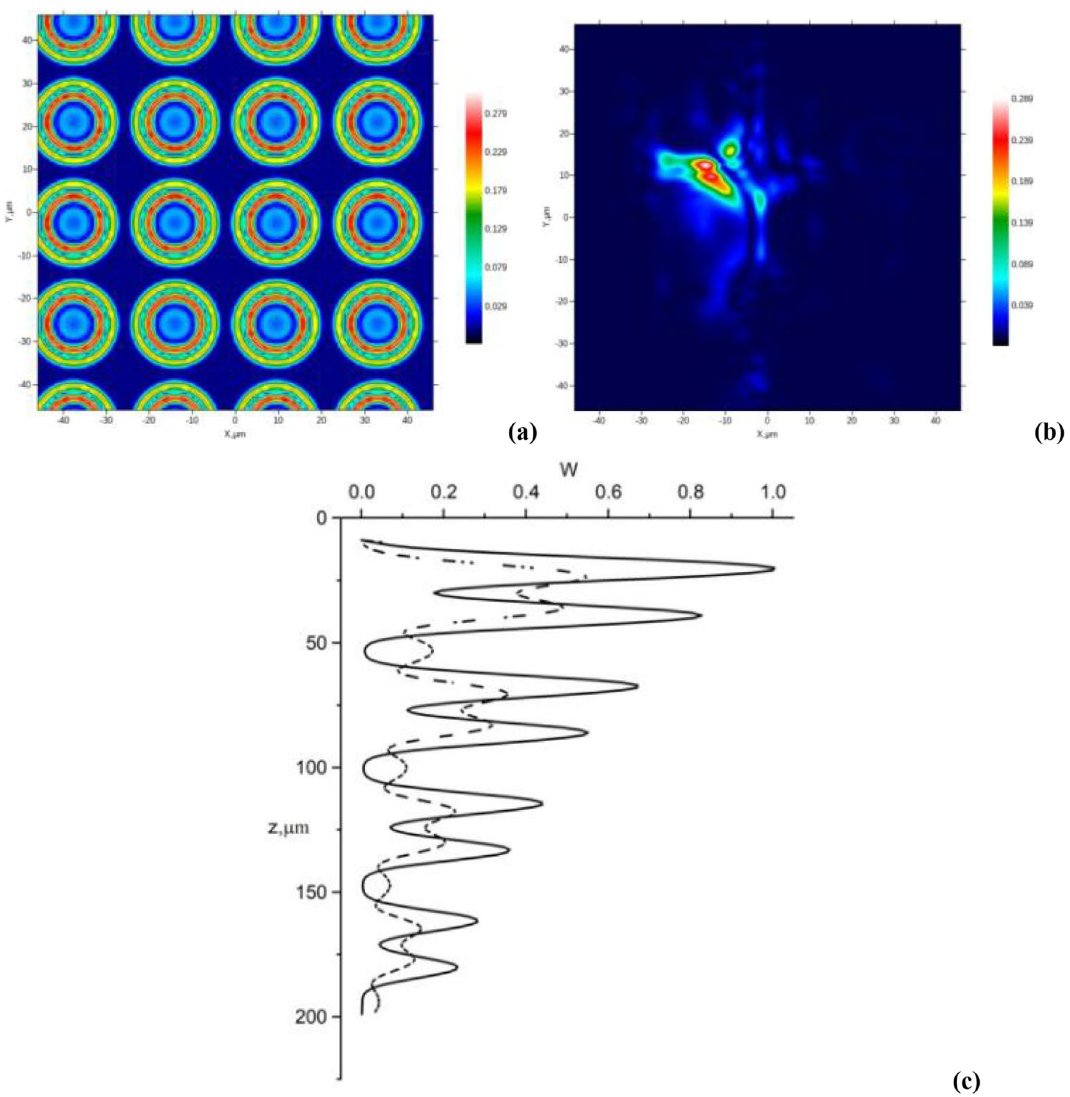
Figure 4. Numerical simulation of OCT-images of AT layers: the reflection coefficient R ( 100 µ m , r ⊥ ) at the 100 μm-depth ( a ), and the transverse structure of the reflected from this layer light beam ( b ) for AT fragment with 8 cell-layers along z -direction; examples of the A-scans for AT( c ); the OCT light beam position on the upper surface of AT corresponds to the cell center (dash line) or between two cells (solid line) for AT fragment with 8 cell-layers along the z